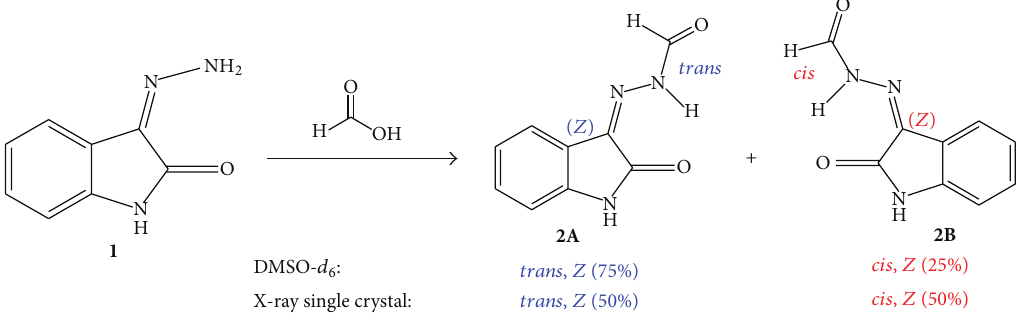
Figure 1: The synthesis of compound 2 which exists as cis and trans amide rotomers in DMSO- 𝑑 6 ( cis : trans = 25 :75). The X-ray analysis showed the Z geometrical isomer of 2 around –C=N– for cis and trans amide rotomers.